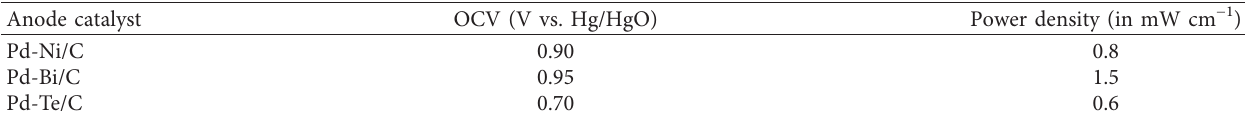
Table 2: Comparison of the home-made direct glucose functionalized C (DGFC) power output on different binary Pd-based catalysts: Pd- Ni/C, Pd-Bi/C, and Pd-Te/C.